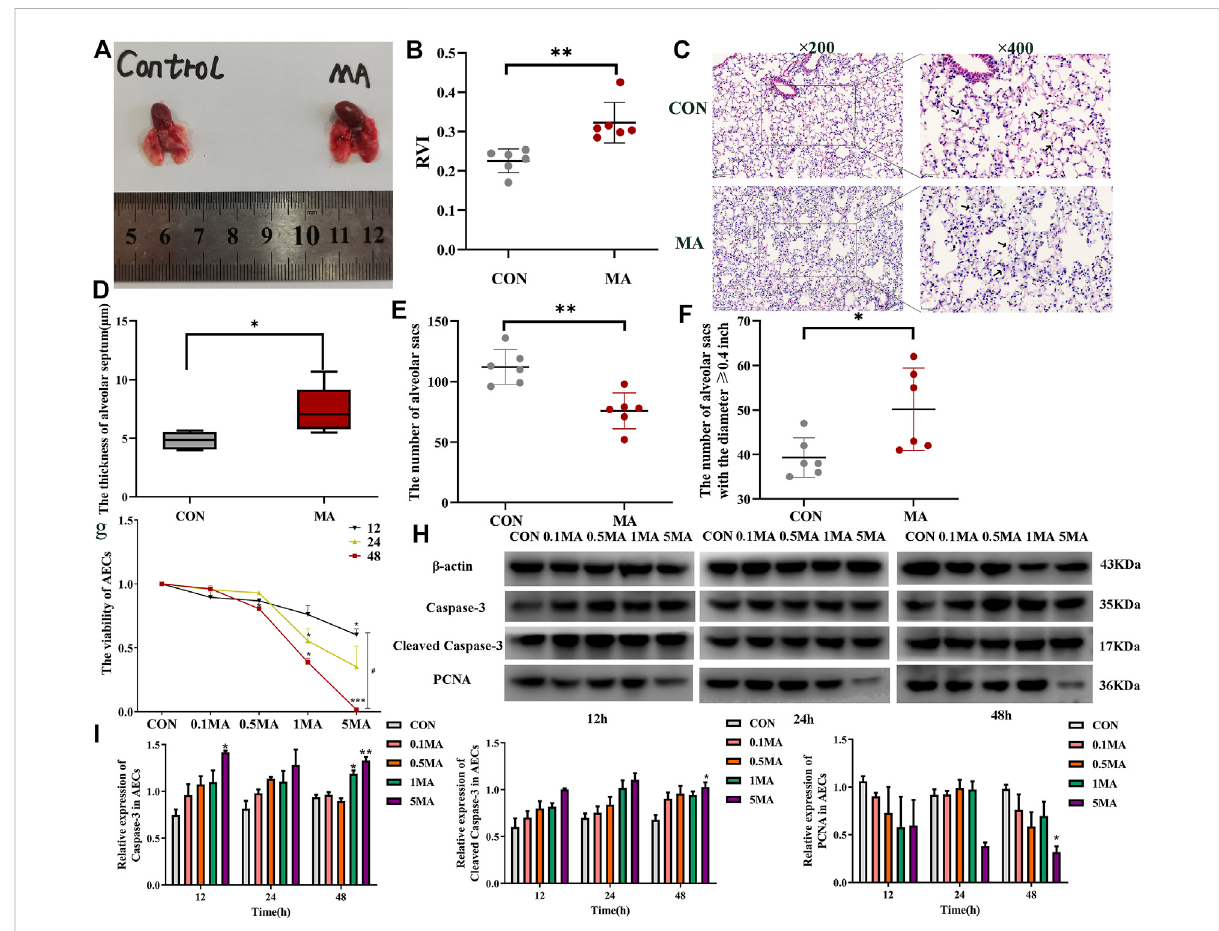
FIGURE 2 MAinducedchroniclunginjury. (A) MicelungsintheCONgroupandtheMAgroup. (B) RVIindifferentgroups. (C) Morphologicalanalysisofthe mice lungs by HE staining. Magni fi cation: ×200, ×400. The black arrows indicate the normal lung tissues in the CON group and the damaged lung tissues in the MA group. (D) The thickness of the alveolar septum in the mice lung, n = 6. (E) Number of alveolar sacs in the lung of the mice in the CONandtheMAgroups,n=6. (F) NumberofalveolarsacsinthelungofthemiceintheCONandtheMAgroupswiththediameter ≥ 0.4inches, n = 6. (G) Viability of AECs on 0.1 mM, 0.5 mM, 1 mM, and 5 mM MA exposure after 12 h, 24 h, and 48 h using CCK-8 assay, n = 3. (H , I) Effect of different dosages and exposure time of MA on caspase-3, cleaved caspase-3 and PCNA expression was detected by western blots, n = 3. Data are expressed as mean ± standard deviation, * p < 0.05 vs. CON, ** p < 0.01 vs. CON, *** p < 0.001 vs. CON; # p < 0.05 vs. 5MA/12 h. RVI: Right ventricular index, AECs: Alveolar epithelial cells, CON: The control group, MA: The group treated with methamphetamine in mice, 0.1 MA: 0.1 mM methamphetamine, 0.5 MA: 0.5 mM methamphetamine, 1 MA: 1 mM methamphetamine, 5 MA: 5 mM